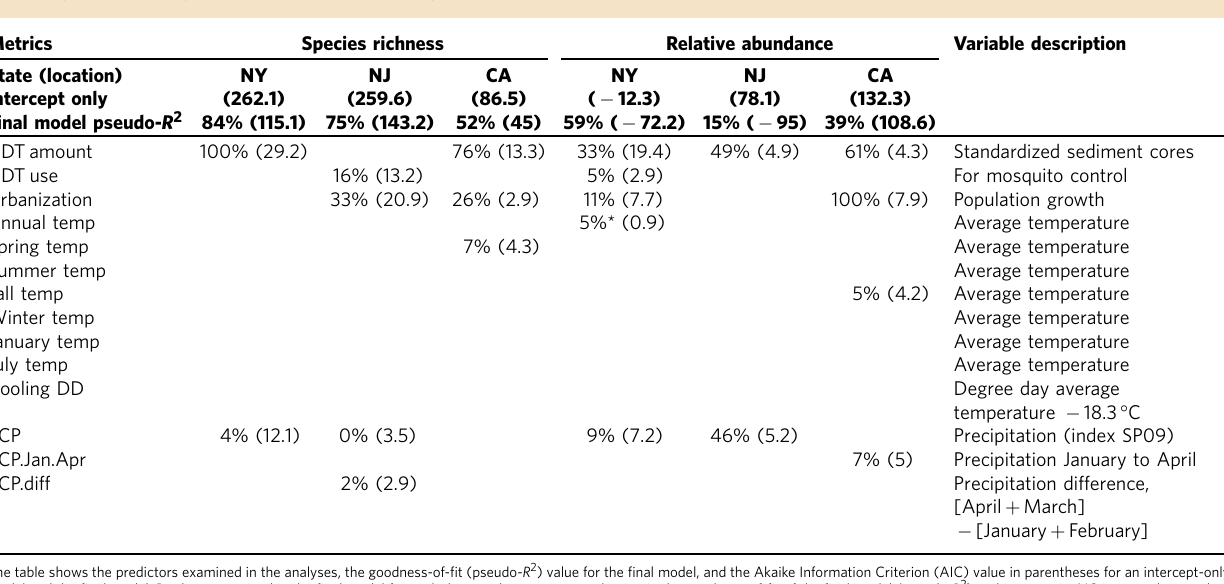
Table 1 | Model comparisons and variation